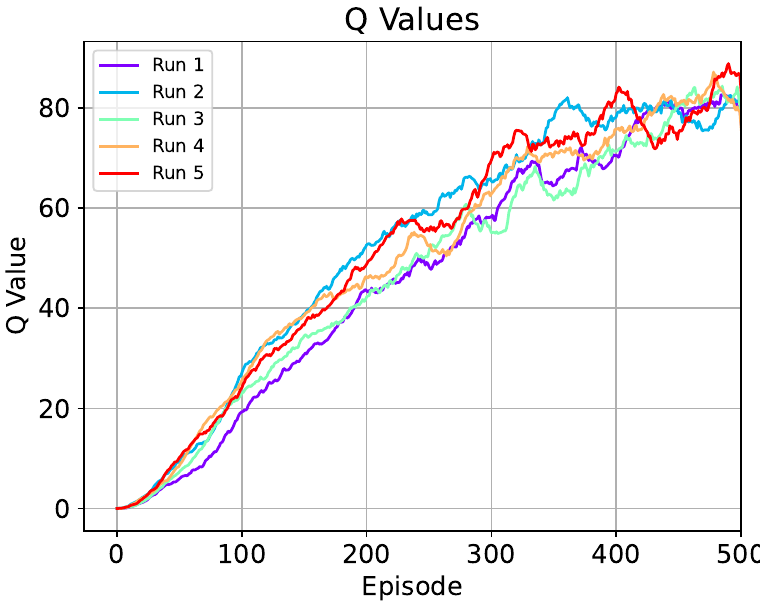
Figure 4. Averaged Q-values for five runs using the DQN algorithm during 500 episodes. The Q-values are averaged for each episode considering twelve possible actions. The results are smoothed in a window of 30 data using a linear